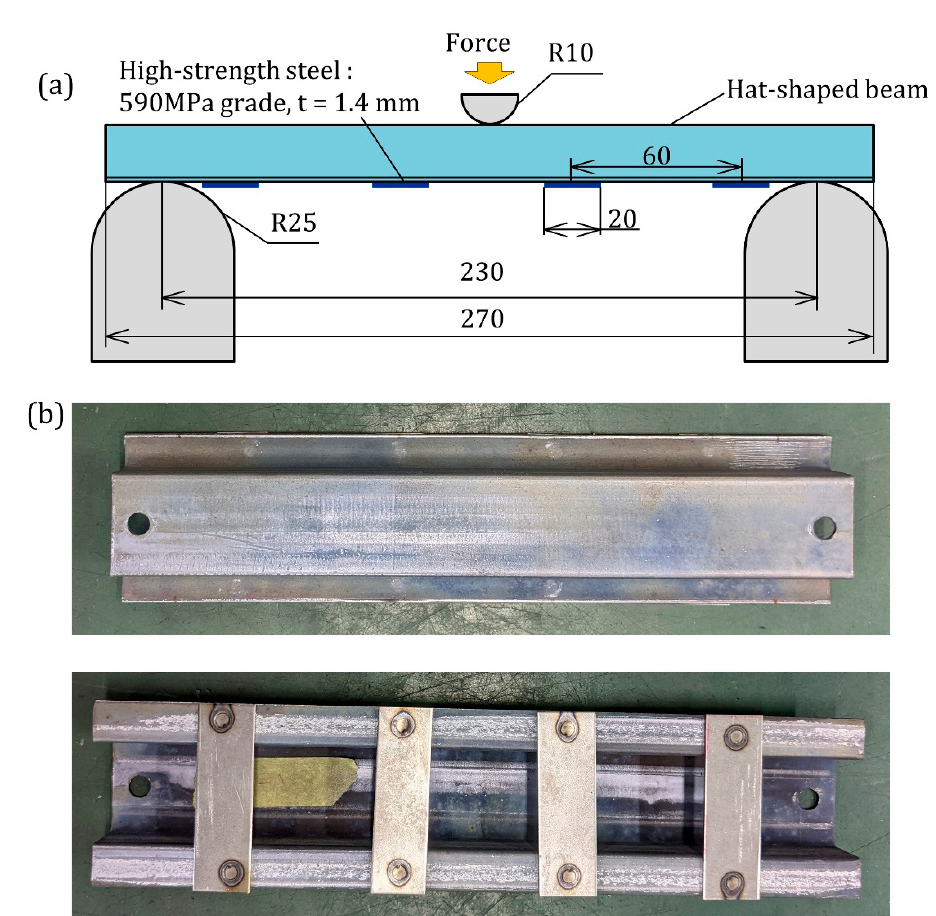
Figure 16. ( a ) Bending setup for hot-hat bent parts and ( b ) bent parts for d L = 10 mm welded with high strength steel sheets.